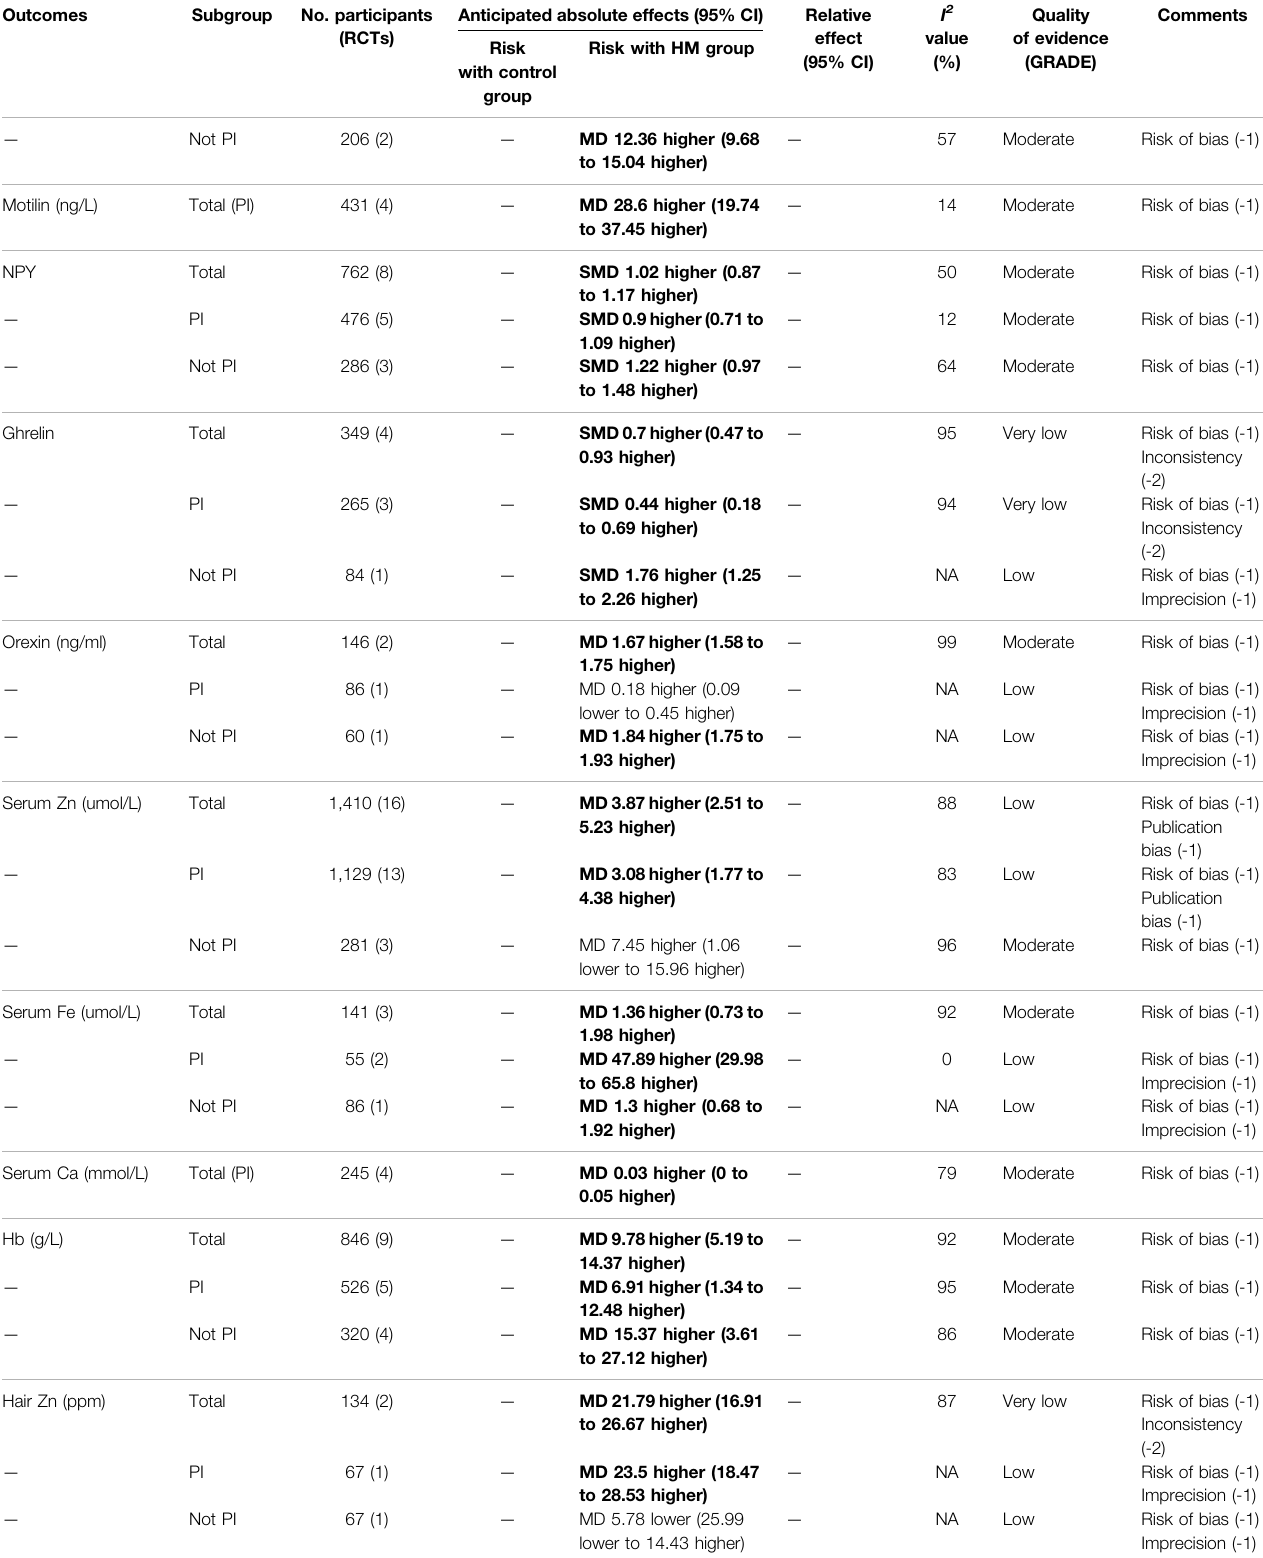
TABLE 1 | ( Continued ) Results of meta-analysis and summary of fi